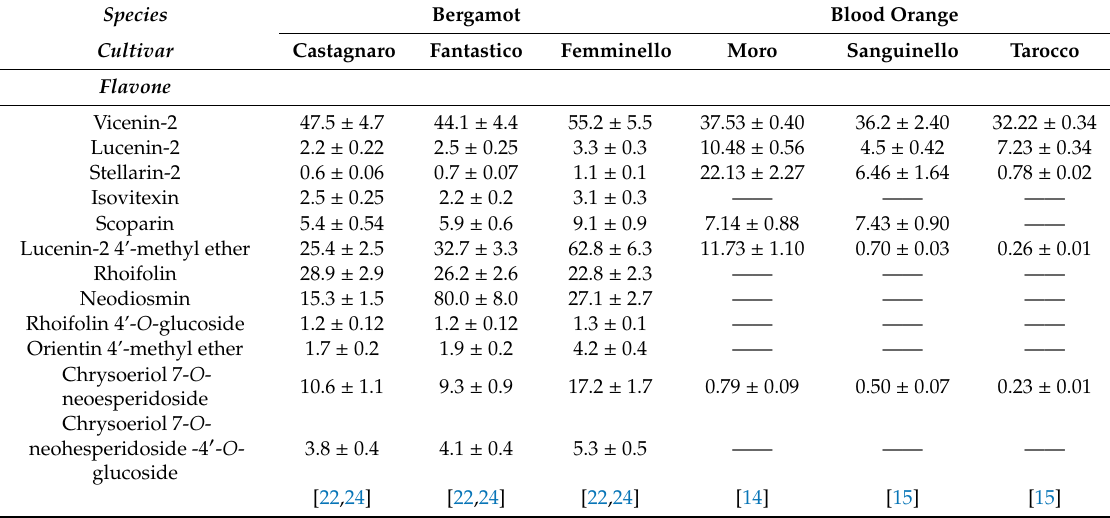
Table 5. Flavone content in bergamot ( Citrus bergamia Risso) and blood orange ( Citrus sinensis (L.) Osbeck)